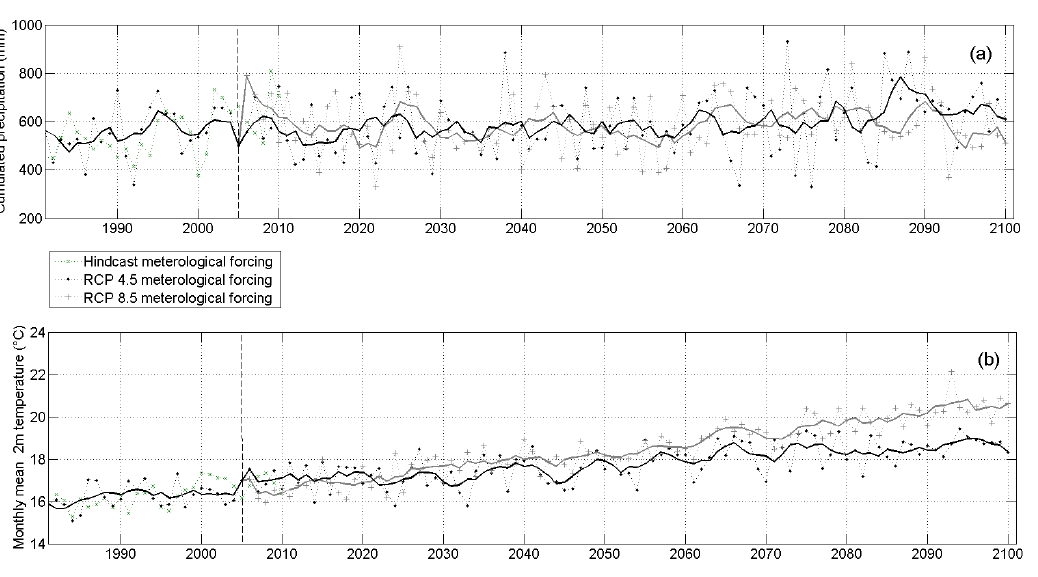
Figure 6. Panel ( a ): annual cumulated precipitation for the Hindcast (green dash line), RCP 4.5 (black dot line) and RCP 8.5 (gray dot line) meteorological forcing. Associated 5 years smoothing for RCP 4.5 (black full line) and RCP 8.5 (grey full line) meteorological forcing. The vertical dash line indicates the end of the common historical period. Panel ( b ) annual mean temperature (same layout).